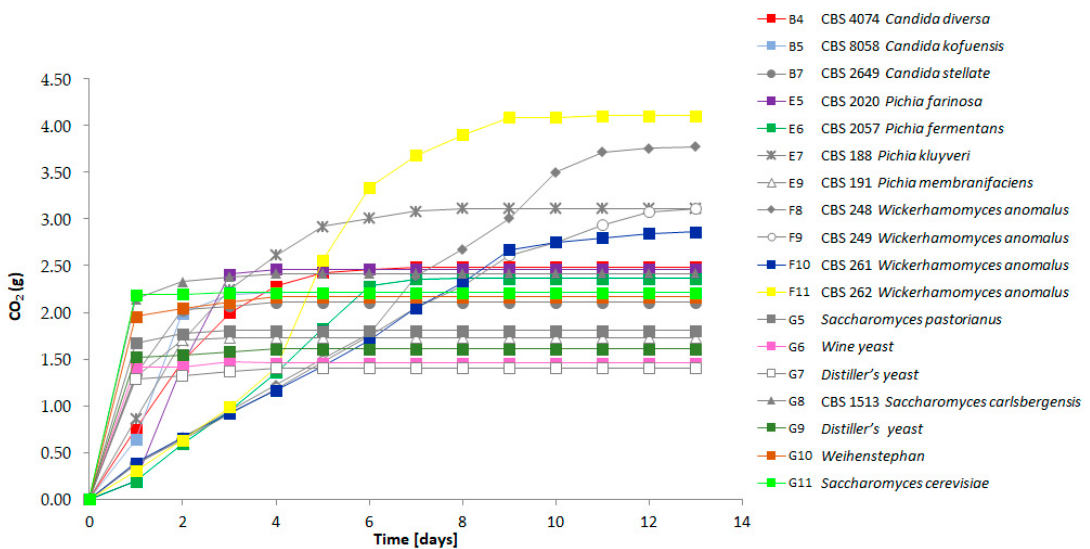
Figure 3. Fermentation profiles of the selected strains representing the detected flavor diversity. The CO 2 release was measured daily for each individual strain (see Table 1 for the nomenclature of strains). Fermentations were followed for 13 days.